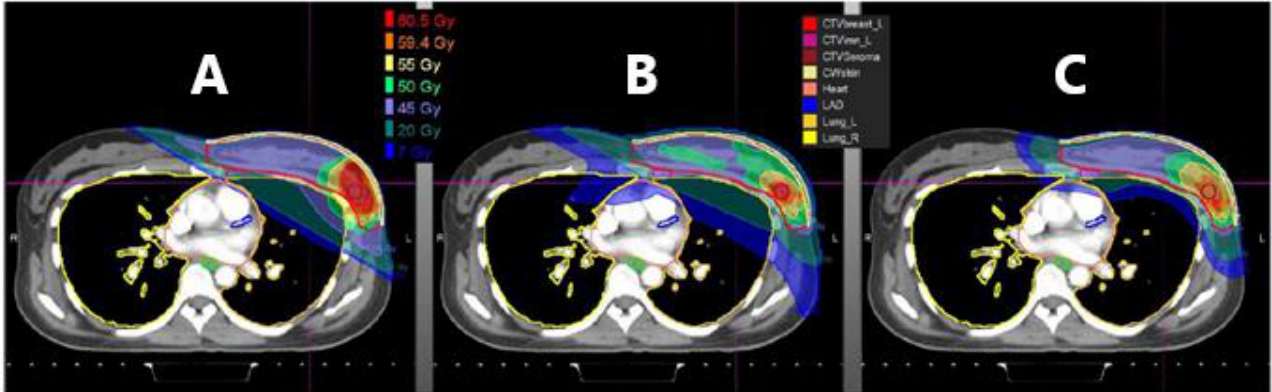
Figure 4. An illustration highlighting differences in the use of ( A ) 3D conformal photon radiotherapy versus ( B ) Volumetric Modulated Arc Therapy (VMAT) versus ( C ) proton radiotherapy (Figure courtesy of Dr. R.B. Jimenez).